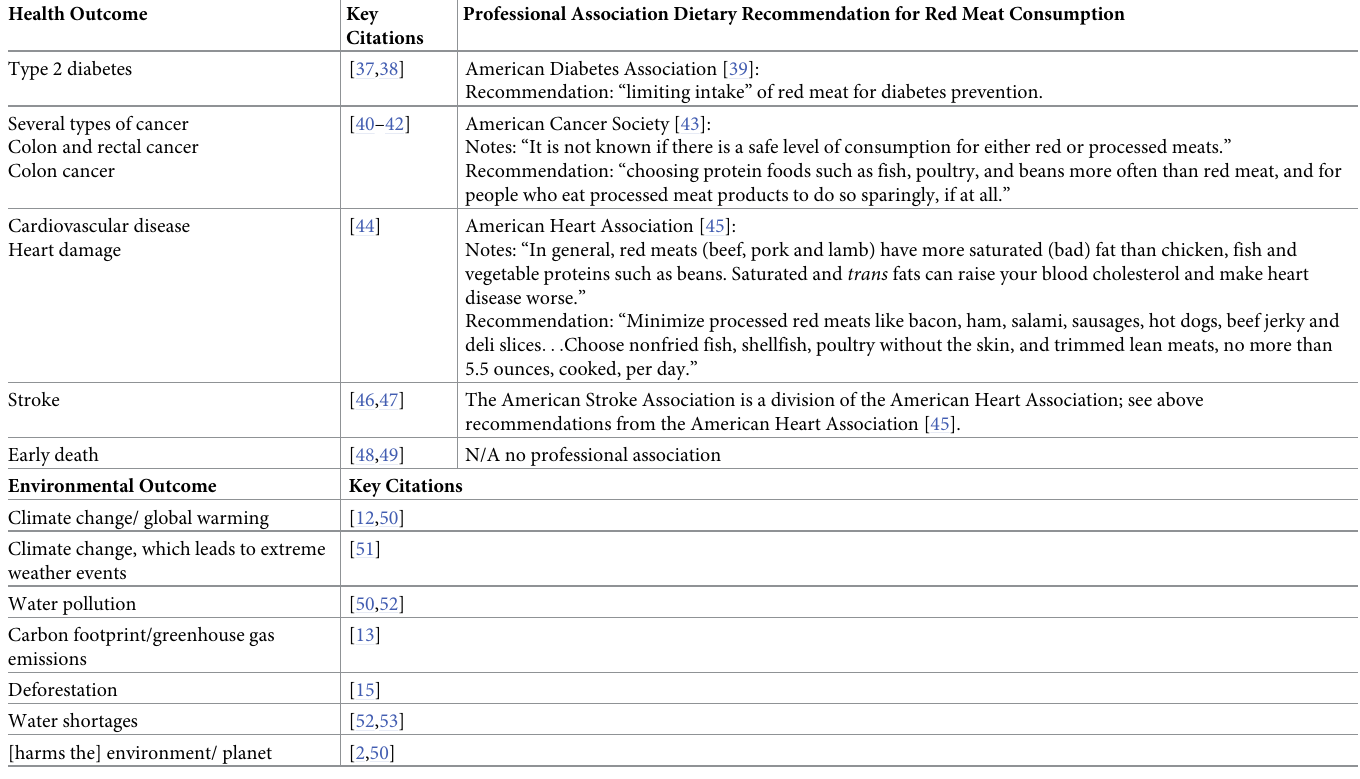
Table 1. Health and environmental outcomes selected for warning messages and supporting